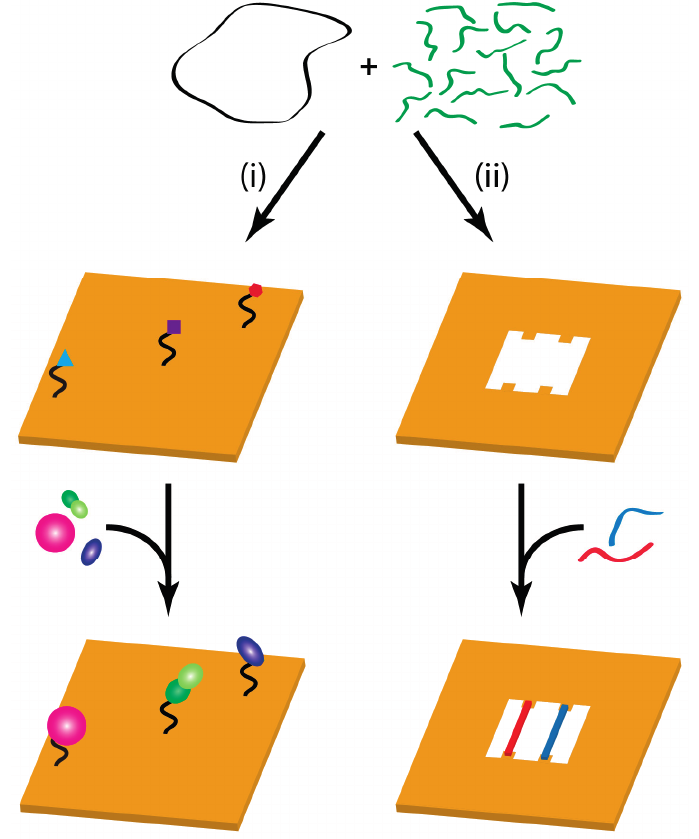
Figure 2. DNA origami nanostructures as substrates for the study of chemical reactions. In strategy (i), a DNA origami is used as a molecular breadboard to arrange molecular entities with high lateral precision while in strategy (ii), a DNA origami frame is constructed for the incorporation of DNA strands of well-defined structure and topology which can then serve as substrates for biochemical